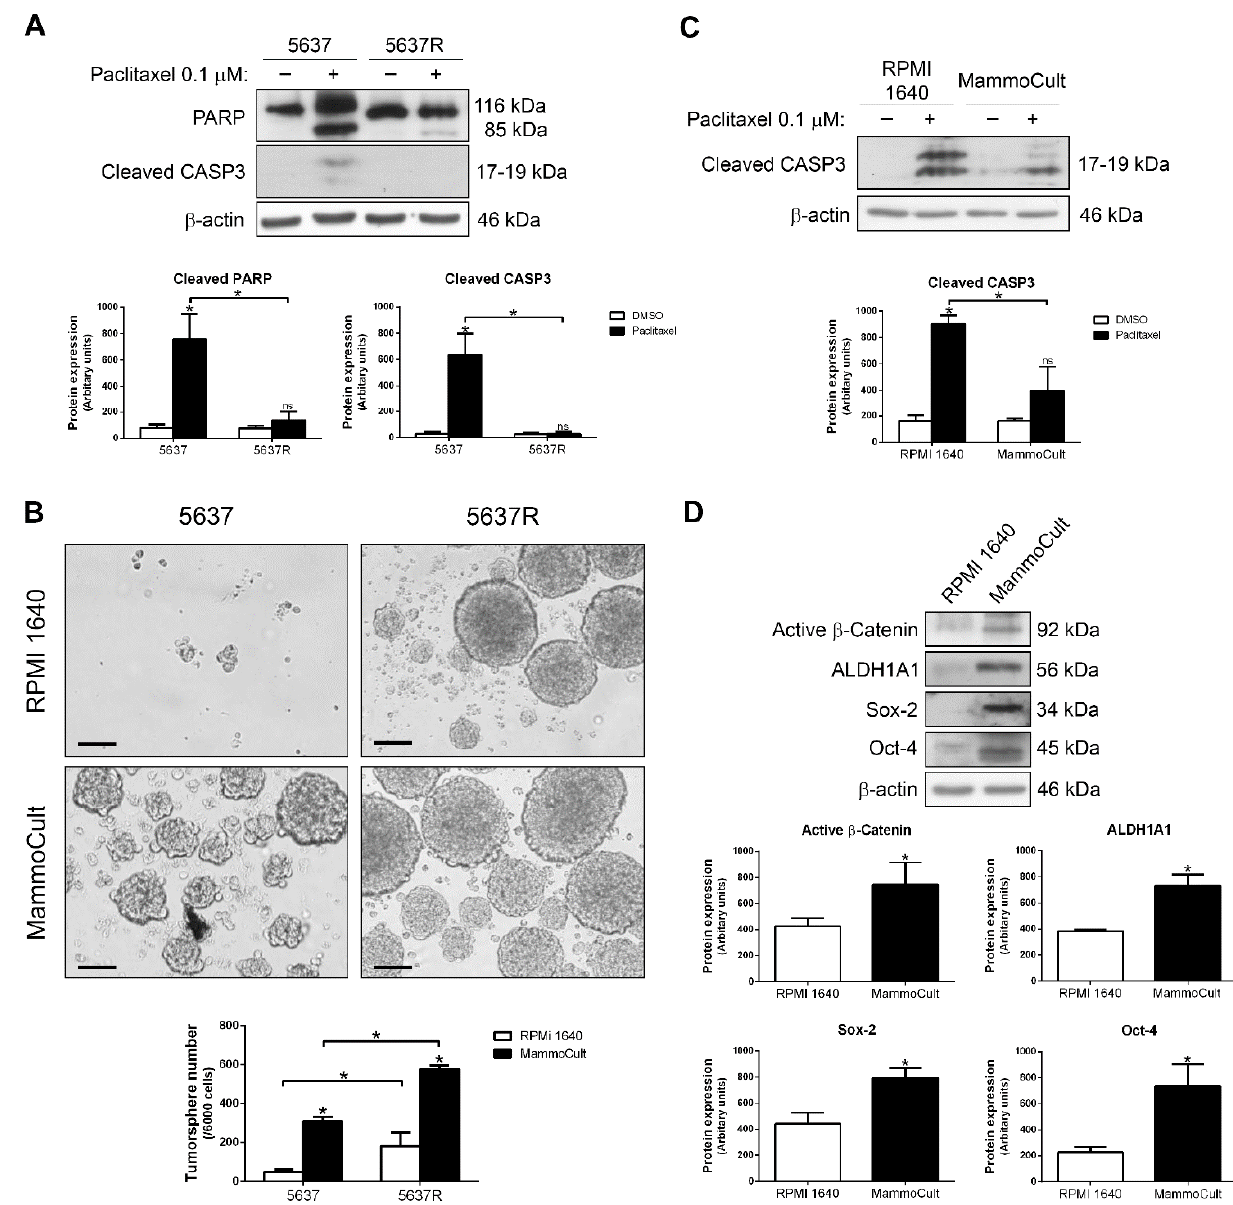
Figure 3. Paclitaxel sensitivity is reduced in 5637 cells grown as tumorspheres. ( A ) Western blots of PARP and cleaved caspase-3 in parental 5637 and paclitaxel-resistant 5637R cells treated with DMSO (vehicle) or 0.1 µM paclitaxel for 48 h. ( B ) Representative images of tumorspheres from parental 5637 and paclitaxel-resistant 5637R cells grown for 5 days in non-adherent conditions with RPMI 1640 or MammoCult TM . Bar, 100 µM. Histograms show the number of tumorspheres per well. ( C ) Western blot of cleaved caspase-3 in 5637 cells cultured in RPMI 1640 and adherent conditions or MammoCult TM and non-adherent conditions and treated with DMSO (vehicle) or 0.1 µM paclitaxel for 48 h. ( D ) Western blots of active β -catenin, ALDH1A1, Sox-2 and Oct-4 in 5637 cells cultured in RPMI 1640 and adherent conditions or MammoCult TM and non-adherent conditions. β - actin was used as a loading control. Histograms show the densitometric analysis of the indicated proteins. Data are presented as mean ± SD. * p value < 0.05 from Student’s t test (n ≥ 3). ns, not significant.